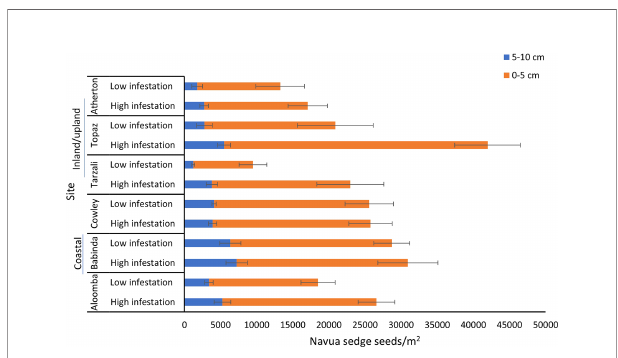
FIGURE 4 | Navua sedge seeds/m 2 present (mean ± standard error) in the upper (0-5 cm) and lower (5-10 cm) soil depths in high and low infestation plots in each of the study site. Aloomba, Babinda and Cowley are coastal sites and Tarzali, Topaz and Atherton are inland/upland sites. N= 4-6 plots per site per infestation level per soil depth.